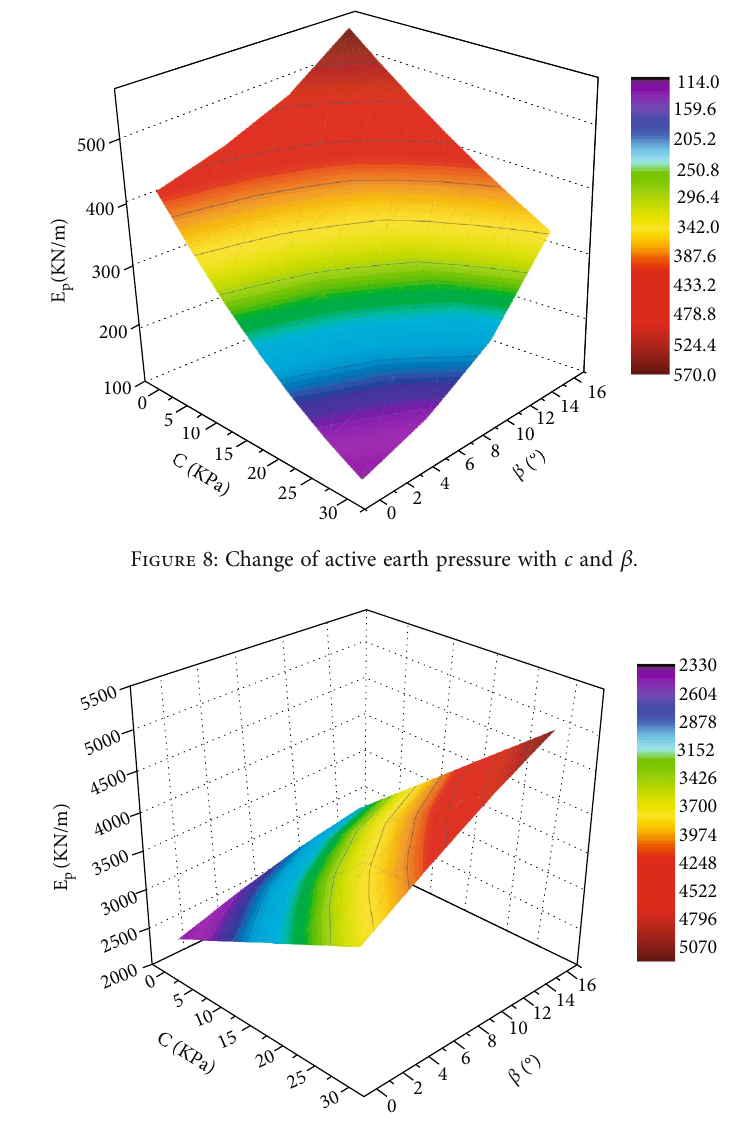
Figure 9: Change of passive earth pressure with c and β .